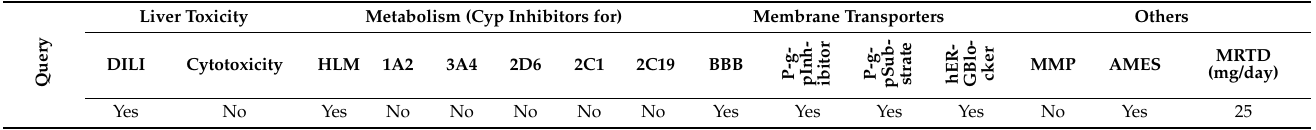
Table 7. The ADMET analysis results of AIGT show it to be non-toxic, especially as an hERG blocker.